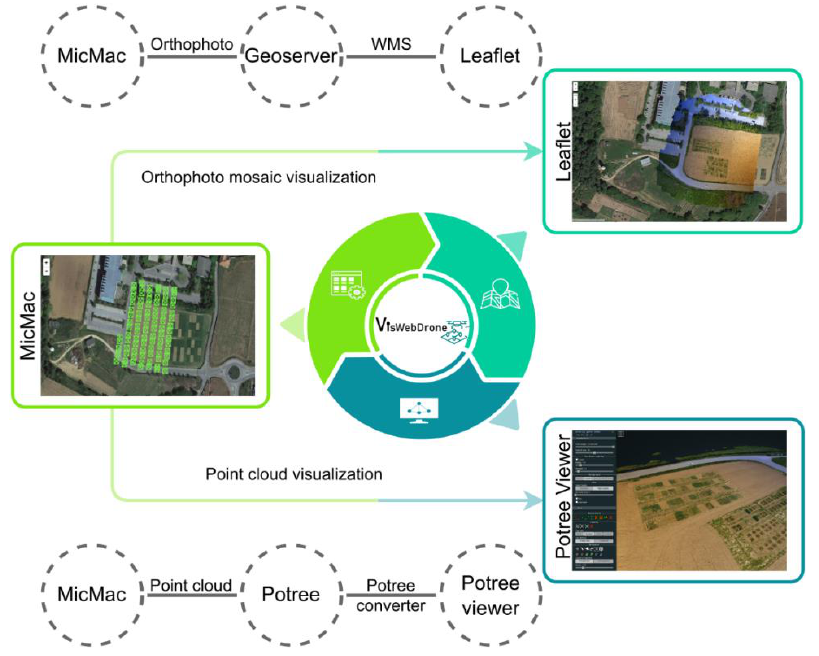
Figure 3. Architecture of the proposed web application.